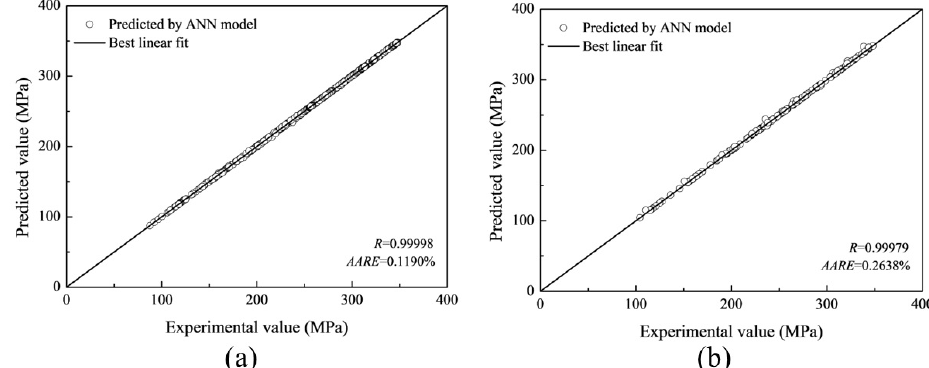
Figure 4. Correlation between experimental and predicted flow stresses for (a) the training procedure and (b) the testing procedure.